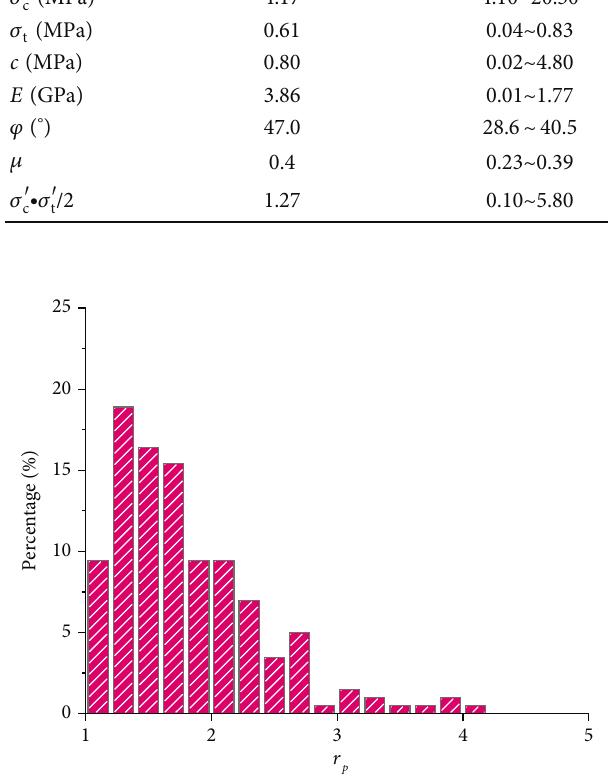
Figure 7: Distribution of shape factor r